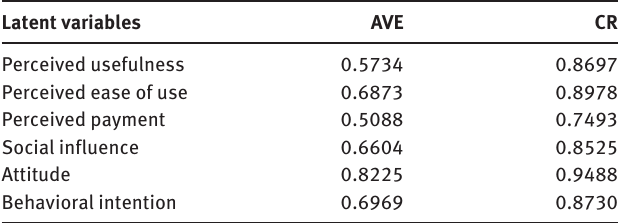
Table 2. AVE and